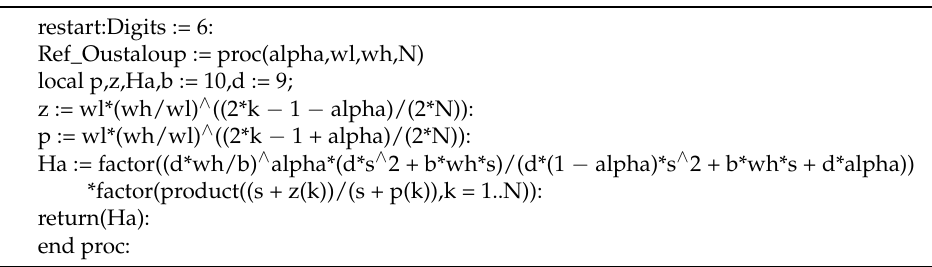
Table 7. Refined Oustaloup’s approximation coded in Maple 18